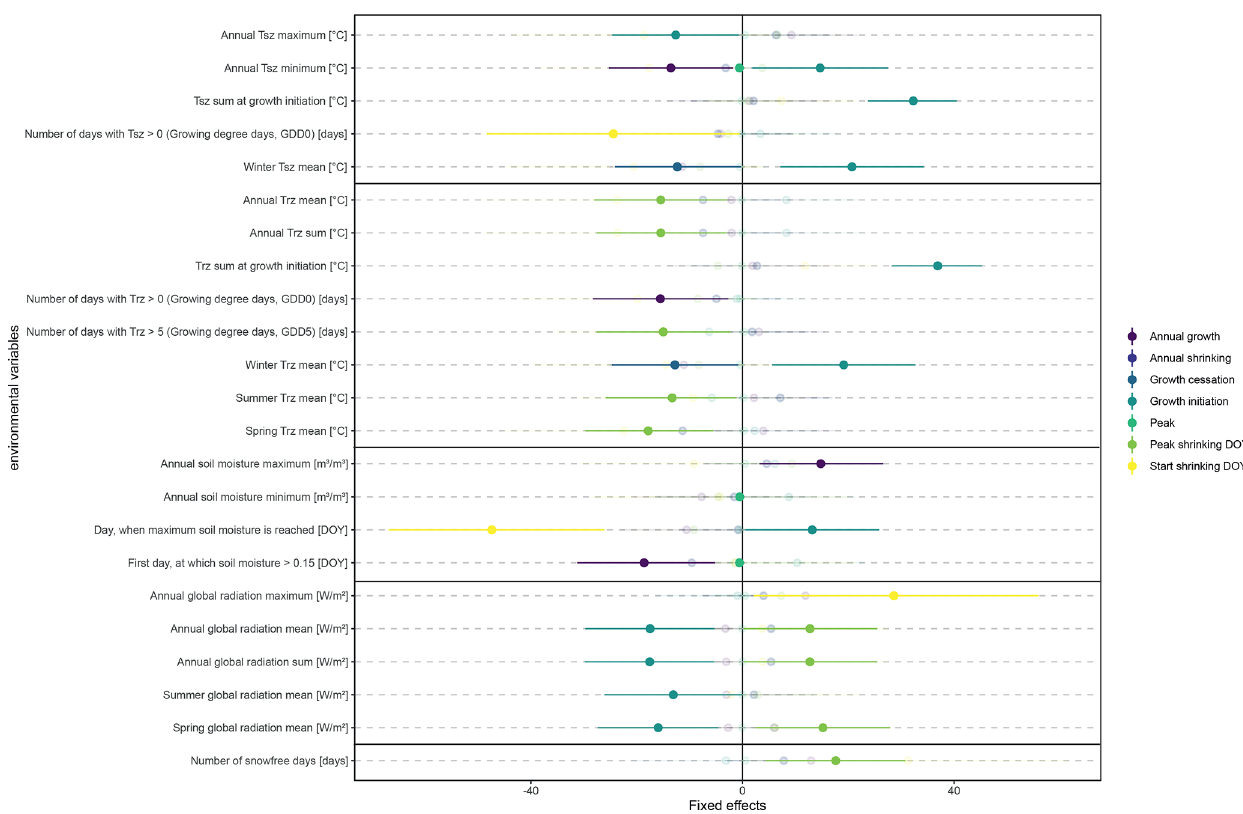
Figure 5. Fixed effects and associated confidence intervals from linear mixed-effect models, modeling key parameters of stem change (dependent variables) from key environmental parameters characterizing on-site environmental conditions (for years with a total annual growth > 0). The environmental parameters are presented in Table 1, while the dependent variables included (i) total annual growth, defined as irreversible stem increment in comparison to the previous year; (ii) total annual shrinking, defined as stem shrinking during the winter months, after the end of the growing season; (iii) timing of the main growing season (start and end); (iv) peak growth, defined as the maximum daily growth rate; and (v) timing of the winter shrinking phase, including the start of stem shrinking (usually co-occurring with the maximum annual stem diameter) and peak shrinking, or the day when the minimum winter stem diameter is reached. All dates were given as day of the year (DOY). Only those environmental parameters which were significantly linked to at least one growth parameter are included in the plot. Nontransparent colors indicate